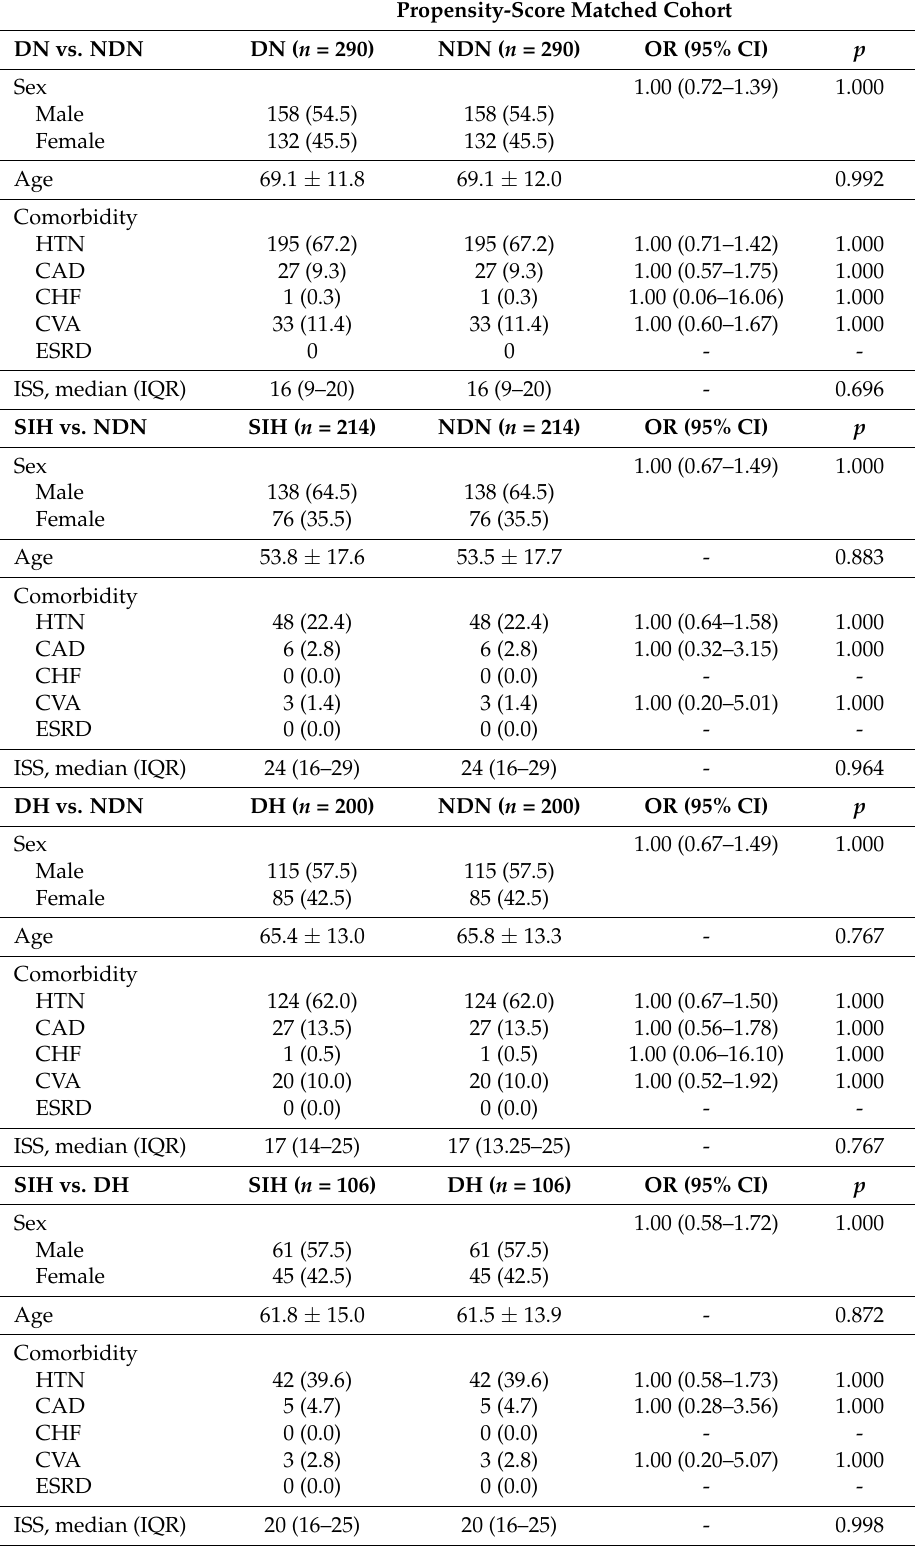
Table 3. Assessment of covariates in patients adjusted in 1:1 greedy propensity-score matching. Propensity-Score Matched